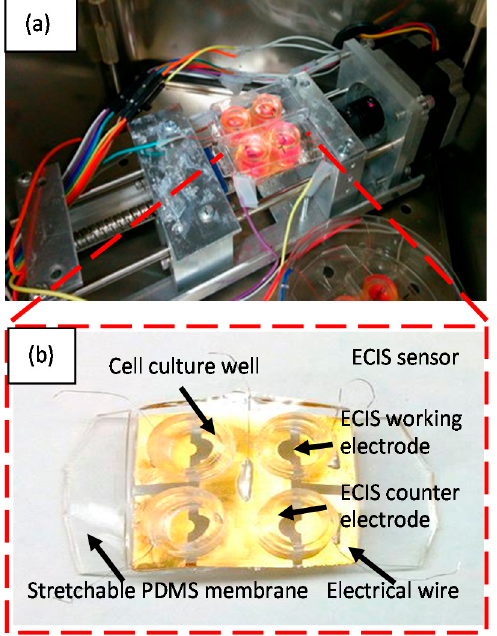
Figure 10. ( a ) A linear motor was used to cyclically stretch the stretchable ECIS sensor. The linear motor with the stretchable ECIS sensor mounted on it was placed inside the incubator; ( b ) Stretchable ECIS sensor. The stretchable ECIS sensors were connected to impedance analyser 4294A, which applied alternating current (AC) between working and counter electrodes and record the impedance data, copied with permission from [82].